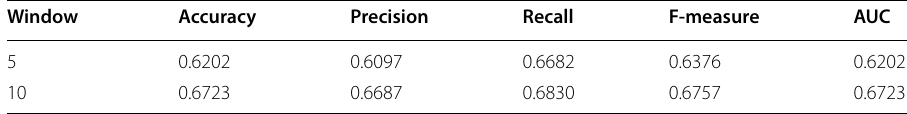
Table 5 Performance of doc2vec on the StockTwits dataset